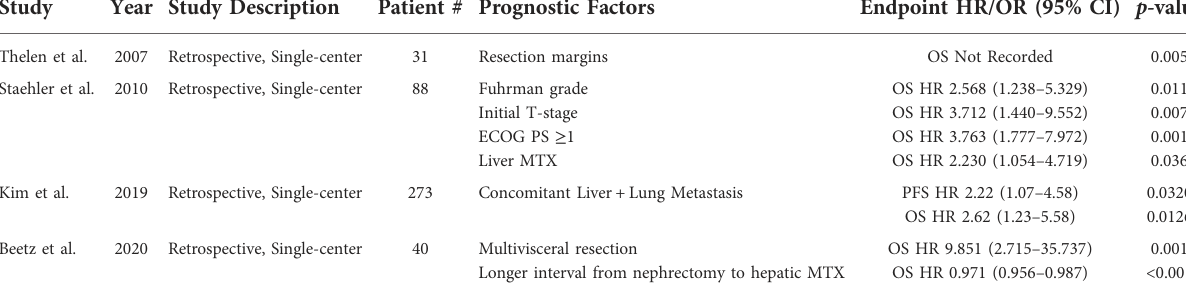
TABLE 4 Prognostic factors identi fi ed via multivariate analysis for metastatic renal cell carcinoma in patients with liver metastases.